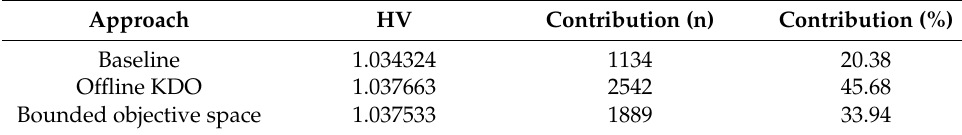
Figure 4. Composite front of the solutions from Figures 1–3. Table 3. HV score and contribution to composite front of the three